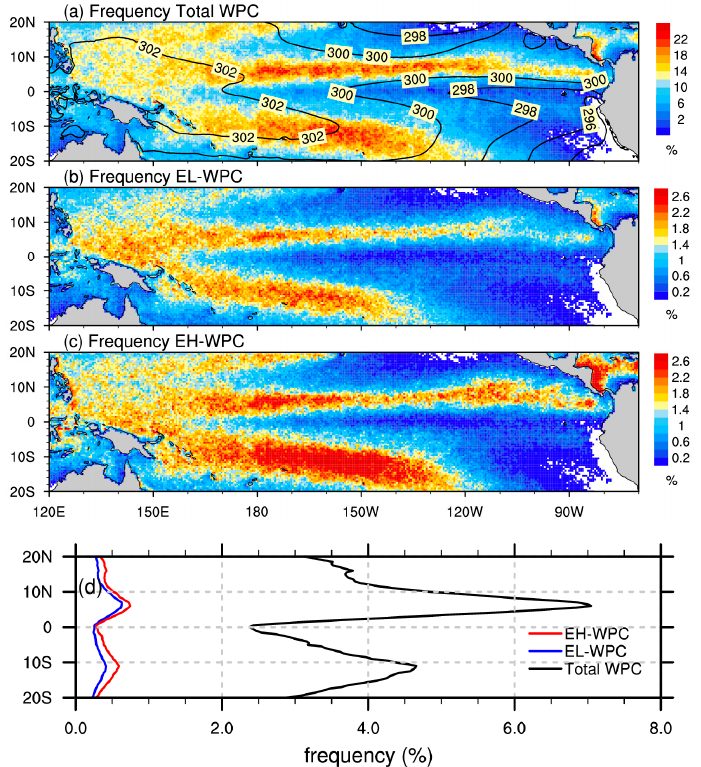
Figure 2. Distribution of the frequency (colored) for ( a ) total, ( b ) extreme-light warm precipitating cloud (EL-WPC), and ( c ) extreme-heavy warm precipitating cloud (EH-WPC), as well as ( d ) their zonal means. Sea-surface temperature (SST) distribution (contours; units: K) is overlapped on ( a ).